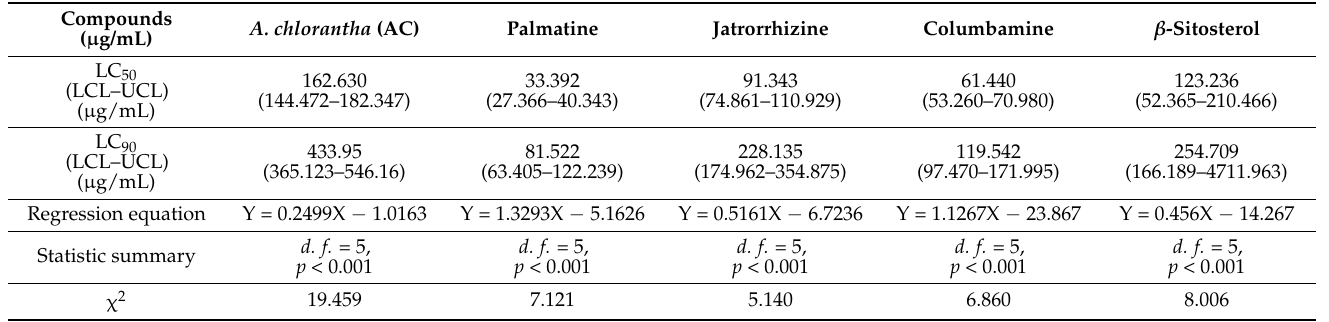
Table 1. Larvicidal activity of the palmatine, jatrorrhizine, columbamine, β -sitosterol, and Annickia chlorantha extract (AC) against the third-instar larvae of the mosquito, Culex pipiens , 24-h